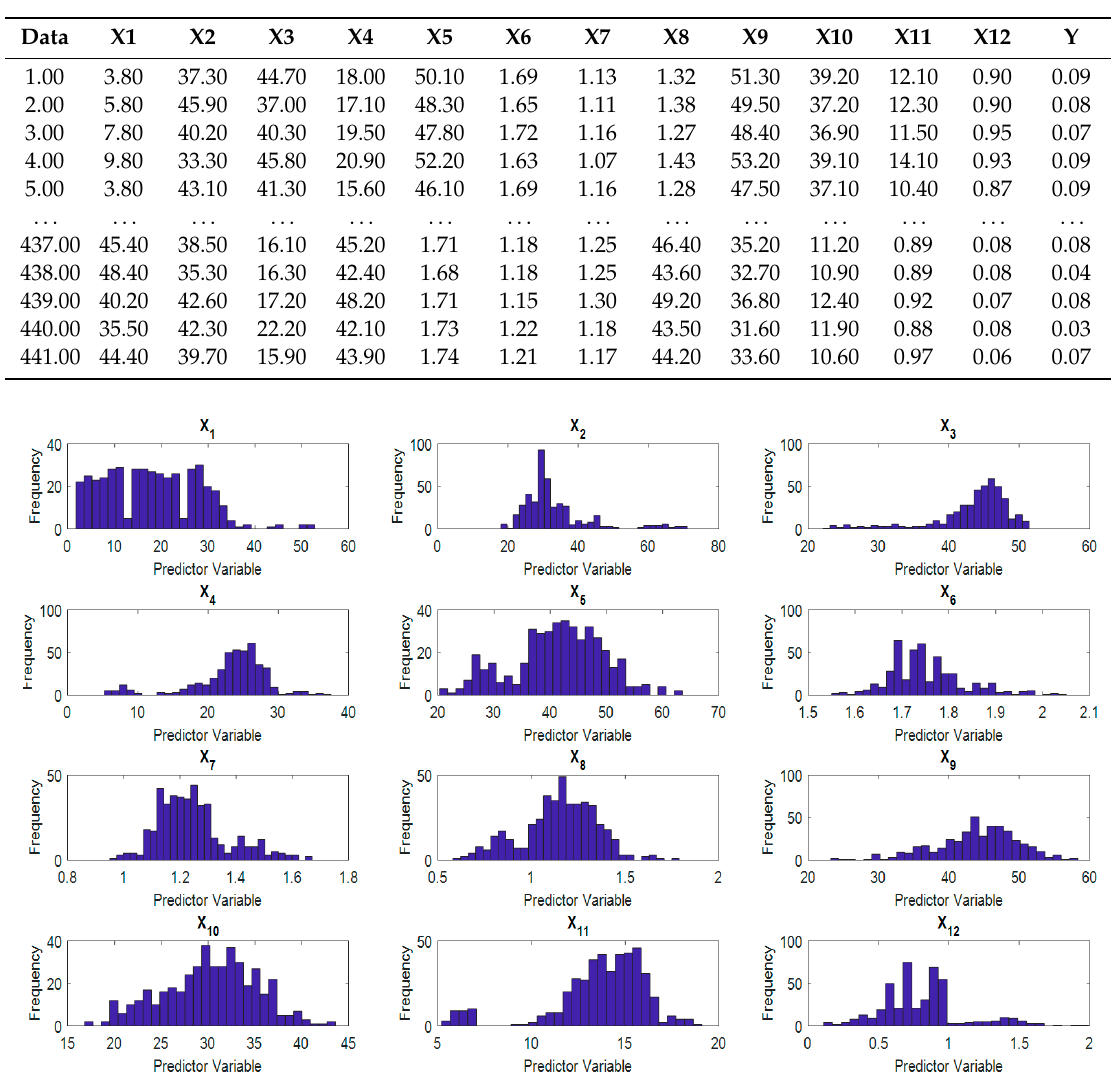
Figure 3. Histograms of compression coefficient’s influencing variables. Appl. Sci. 2019 , 9 , x FOR PEER REVIEW